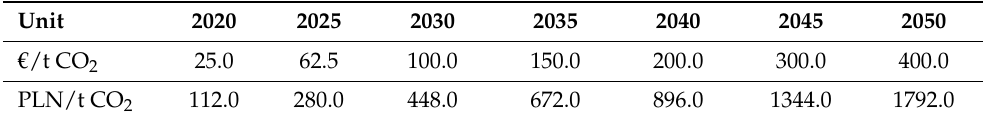
Table 6. Forecast of prices of CO 2 emission